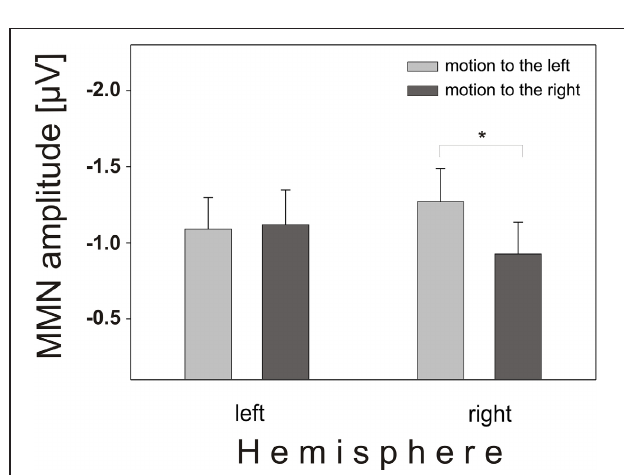
FIGURE 5 | Interaction direction × hemisphere. Mean amplitudes and standard error of MMN for motion to the left (light gray boxes) and motion to the right (dark gray boxes) at electrodes over left hemisphere and right hemisphere scalp positions. Simulated motion to the left caused larger MMN amplitudes over the right hemisphere and vice versa.